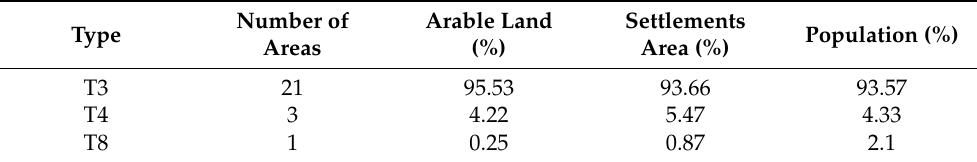
Figure 6. Distribution of decoupling types between permanent rural population and arable land between rural population and rural settlements in the Yellow River Basin (Henan section). Table 3. Characteristics of decoupling types between rural population and rural